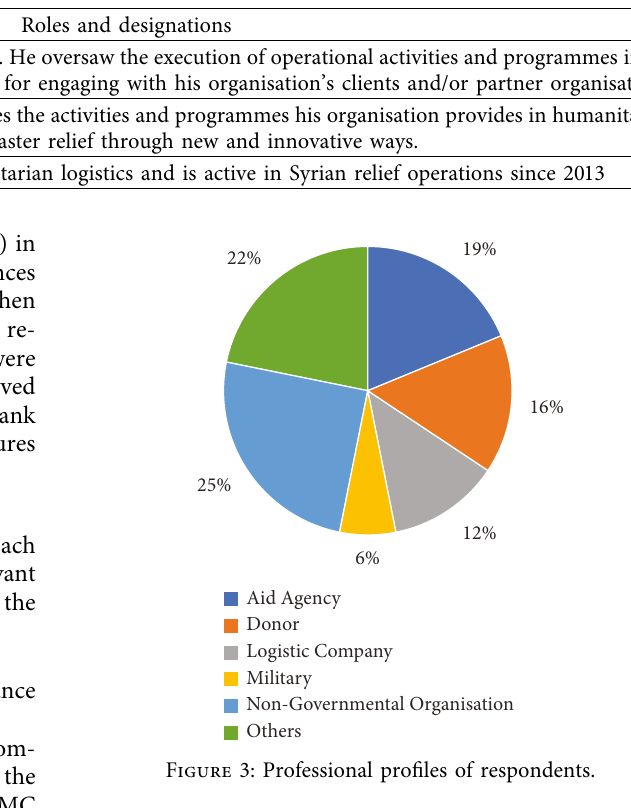
Table 4: Profile of interviewees.